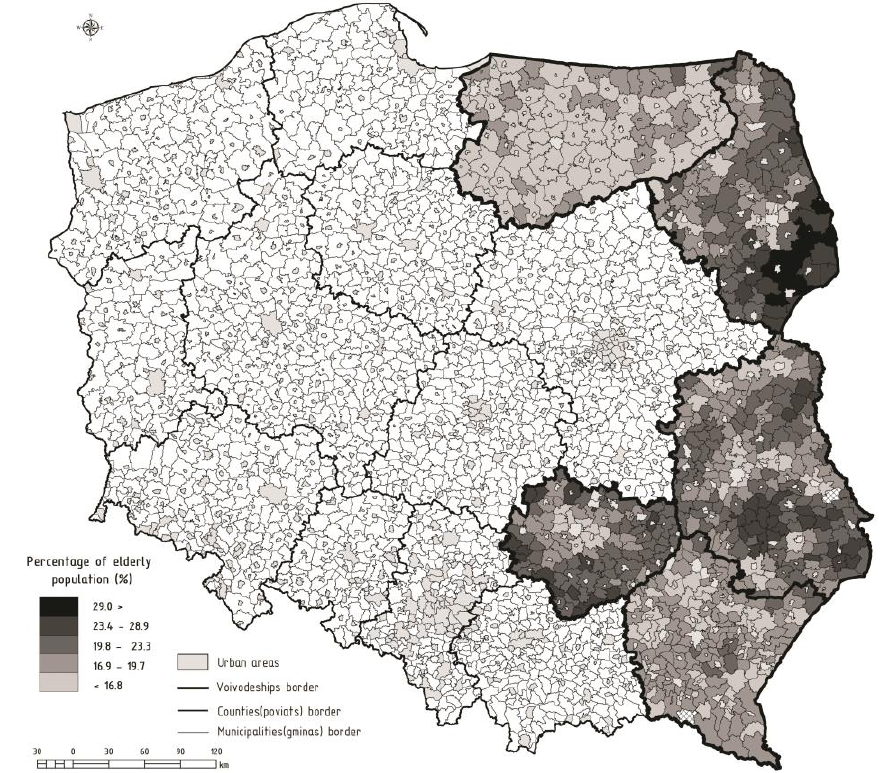
Fig. 5. The percentage of the post-working age population in rural areas of Eastern Poland in 2020 (Source: calculations of the authors)